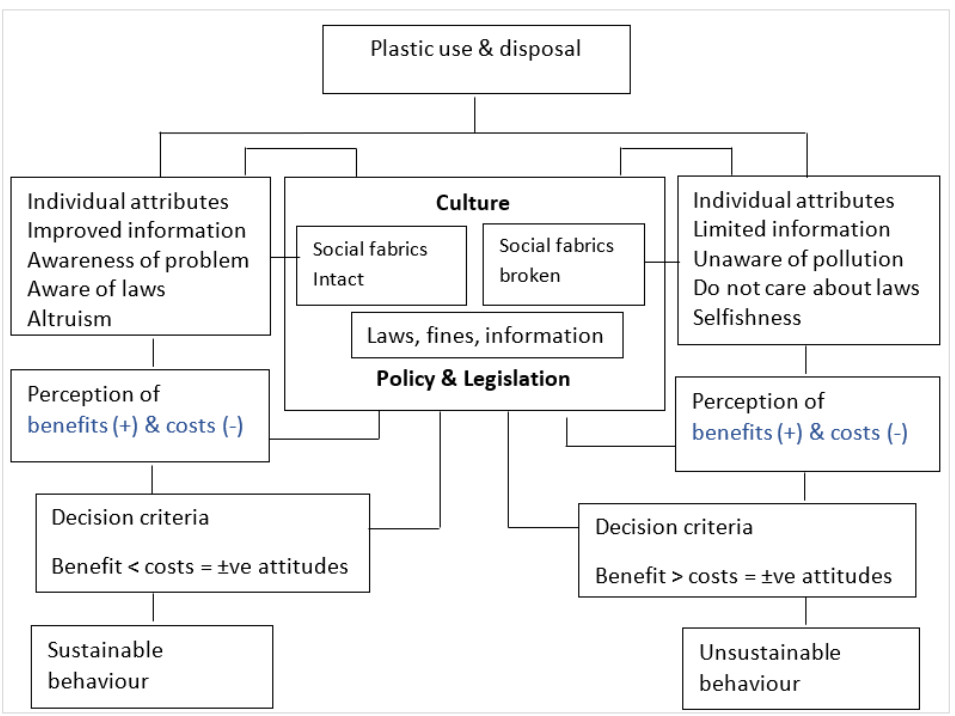
Figure 2. Consolidated theoretical framework linking consumer perceptions with behaviour. Source: Authors.